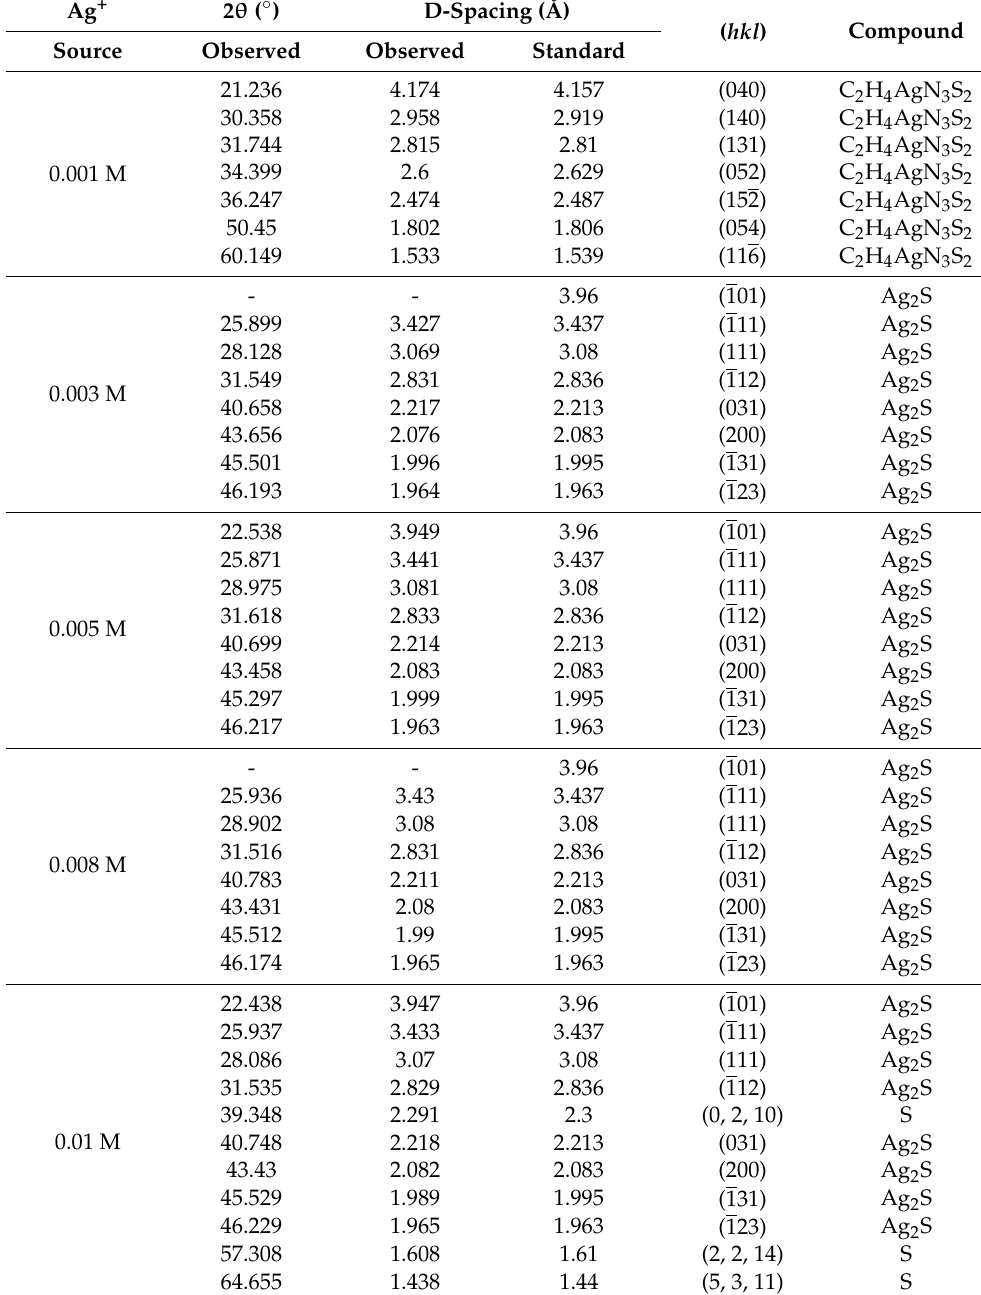
Table 1. XRD data for Ag 2 S/ZnO NRs deposited at various concentrations of AgNO 3 . Ag